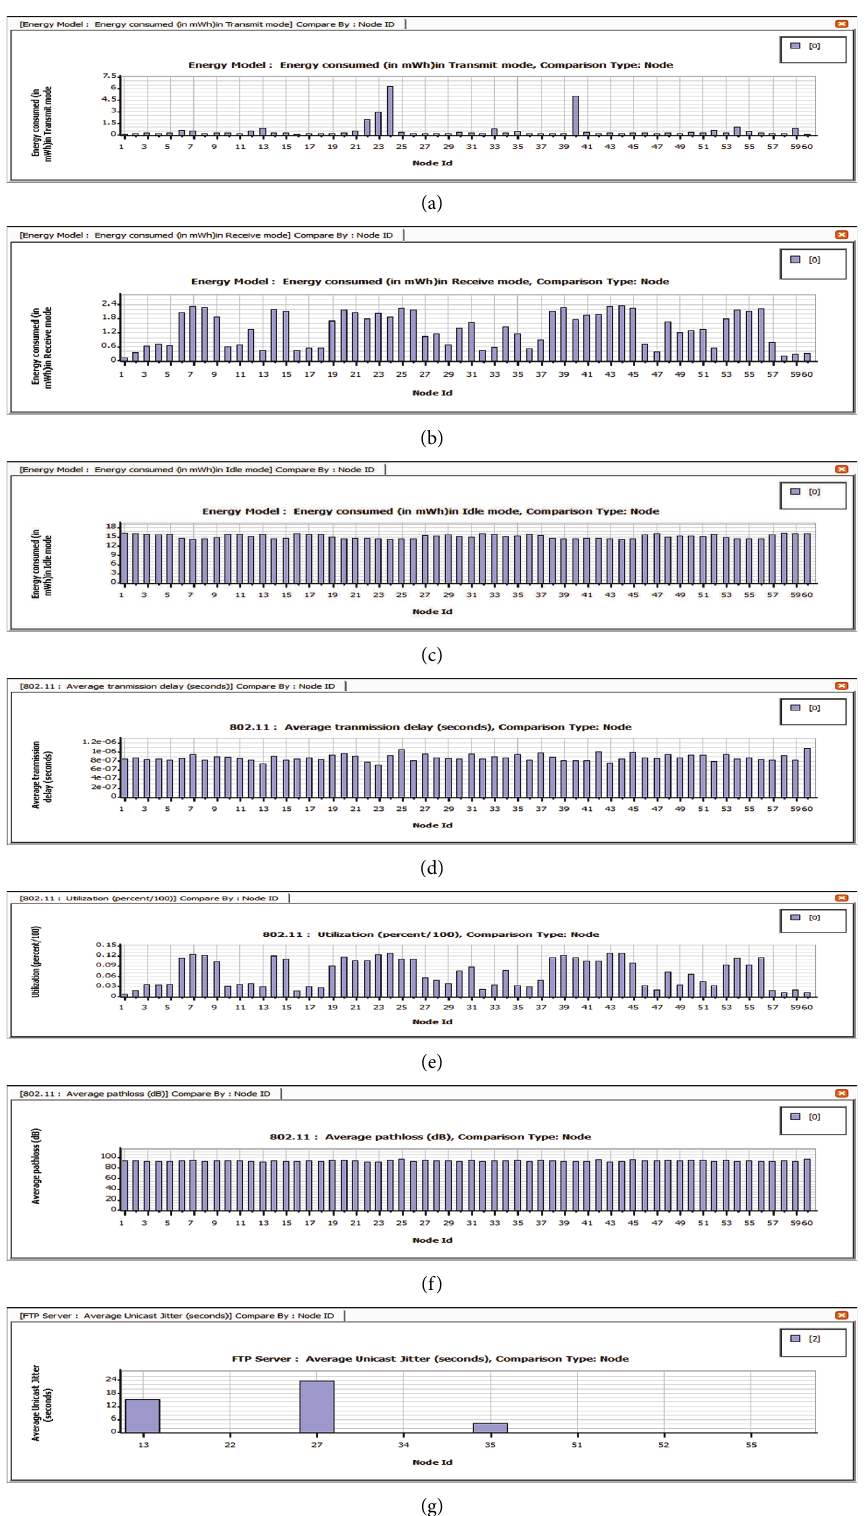
Figure 17: (a) Transmit mode energy consumption of STAR-ORA for FTP deployment. (b) Receive mode energy consumption of STAR- ORA for FTP deployment. (c) Idle mode energy consumption of STAR-ORA for FTP deployment. (d) Average transmission delay of STAR- ORA for FTP deployment. (e) Percentage of utilization of STAR-ORA for FTP deployment. (f) Average pathloss of STAR-ORA for FTP deployment. (g) Average jitter of STAR-ORA for FTP